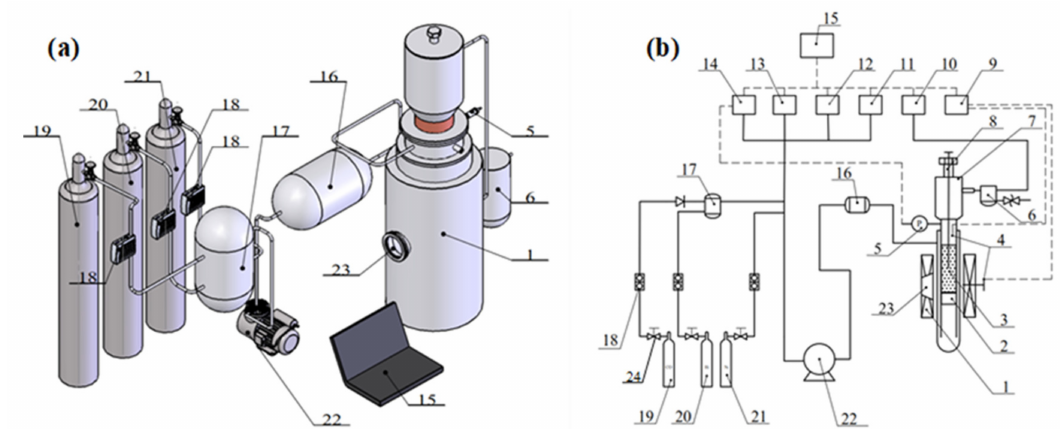
Figure 3. Experimental setup: ( a ) fluidized bed reactor ( b ) flow chart. 1—gasmixing and preheating chamber; 2—gas mixing hole; 3—fluidized bed; 4—K-type thermal couple; 5—pressure sensor; 6—gravity filter; 7—feeding and sampling port; 8.—pressure seal cap; 9—temperature change recorder; 10—gas analyzer; 11—H 2 gas analysis recorder; 12—CO 2 gas analysis recorder; 13—CO gas analysis recorder; 14—pressure change analysis recorder; 15—computer; 16—gas dryer; 17—gasholder; 18—pressure display; 19—CO 2 /COgas cylinders; 20—H 2 gas cylinders; 21—N 2 gas cylinders; 22—booster pump; 23.—heating furnace; 24—gas